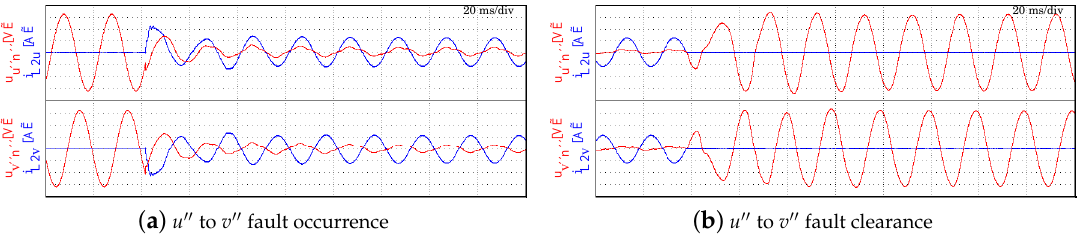
Figure 19. Scenario 2 (phase to phase short-circuit fault). u x (cid:48)(cid:48) n (cid:48)(cid:48) (100 V/div) and i L 2 x (150 A/div). Scenarios 3–4—Three-phase short-circuit and Three-phase to neutral short-circuit.